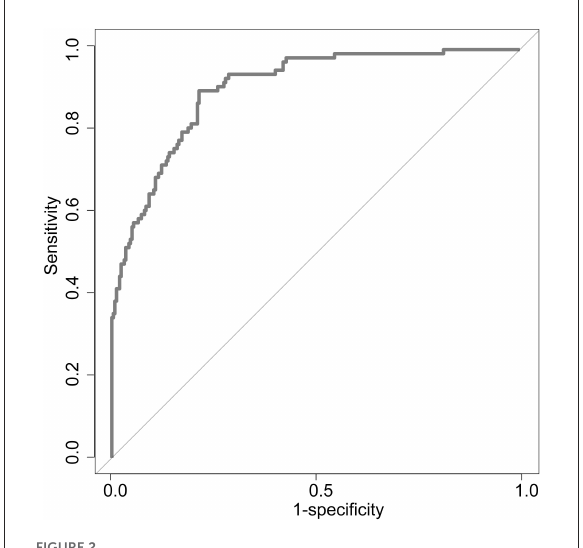
FIGURE2 ROC curve to determine the predictive performance of 1 RDW for poor neurological outcomes recovery. ROC, Receiver operating characteristic; 1 RDW, the third day after IVT red blood cell distribution width – on admission red blood cell distribution